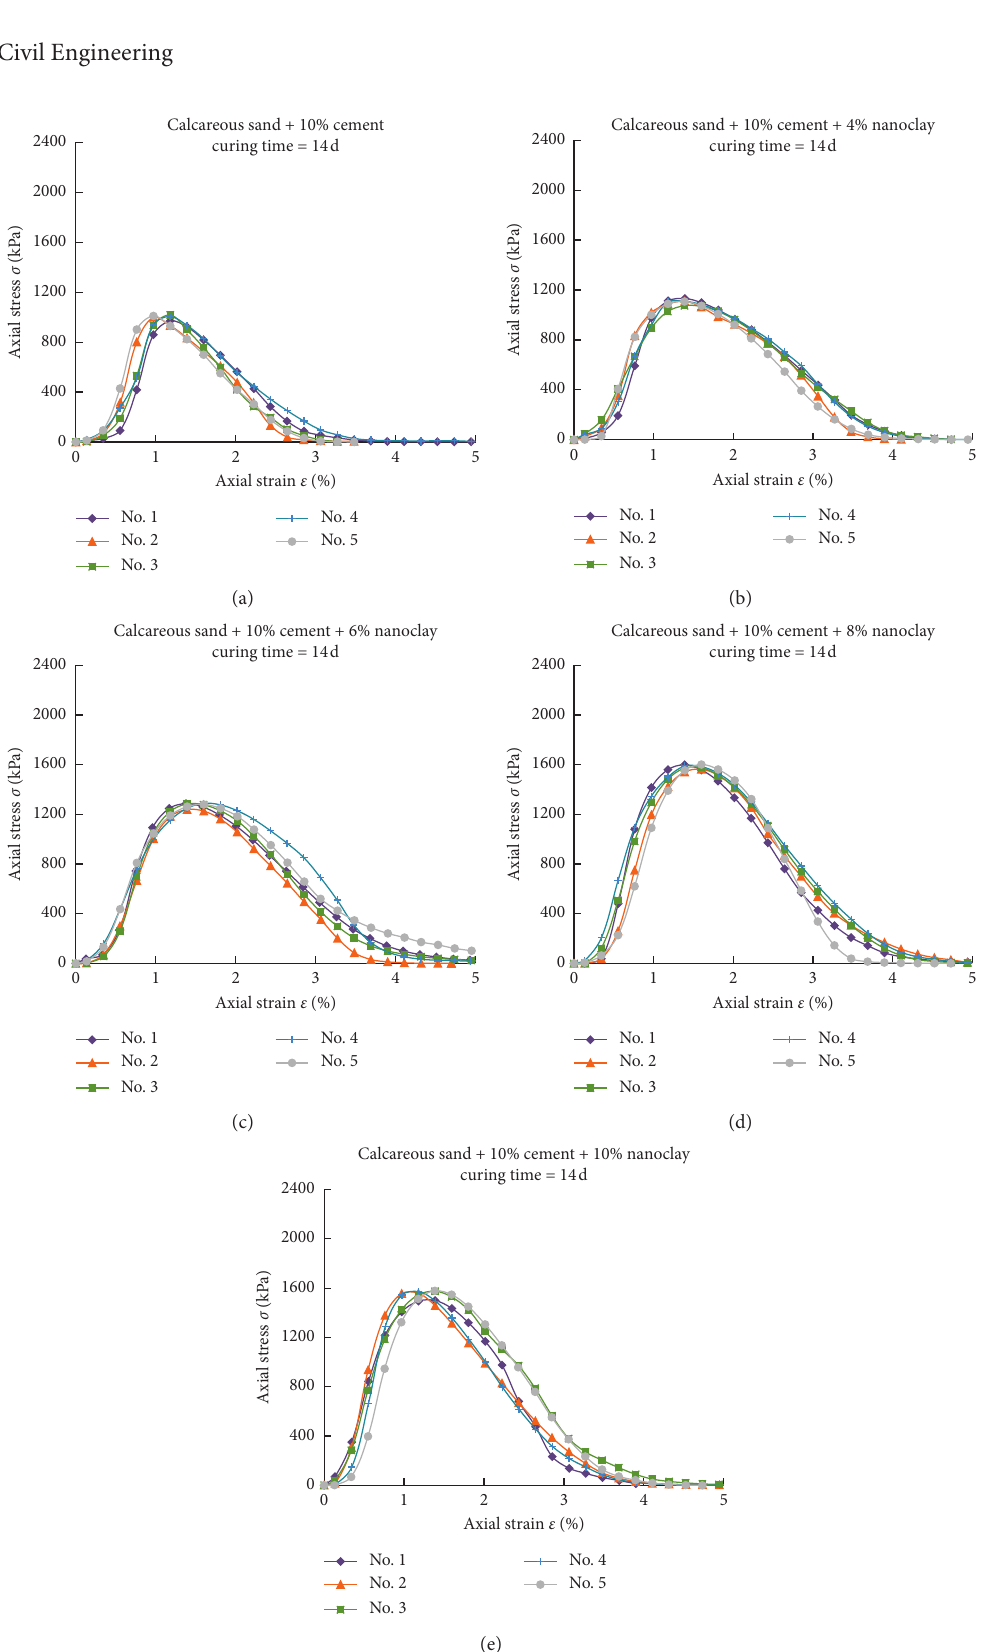
Figure 6: The stress-strain curves of CCS and NCCS on 14d. (a) CCS-14. (b) NCCS-4-14. (c) NCCS-6-14. (d) NCCS-8-14. (e)